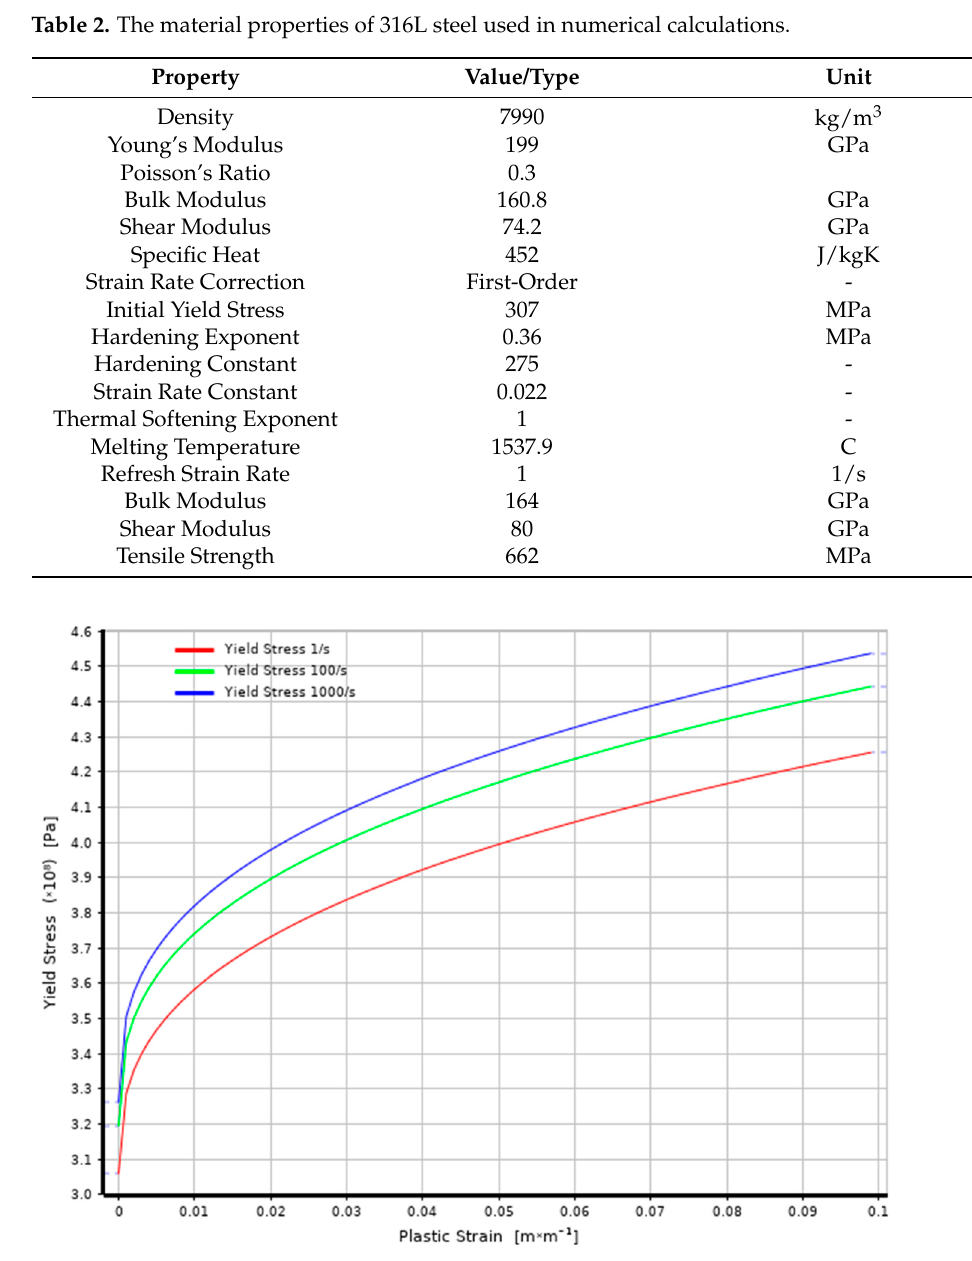
Figure 2. Johnson–Cook strength characteristics for 316L stainless Figure 2. Johnson – Cook strength characteristics for 316L stainless steel.